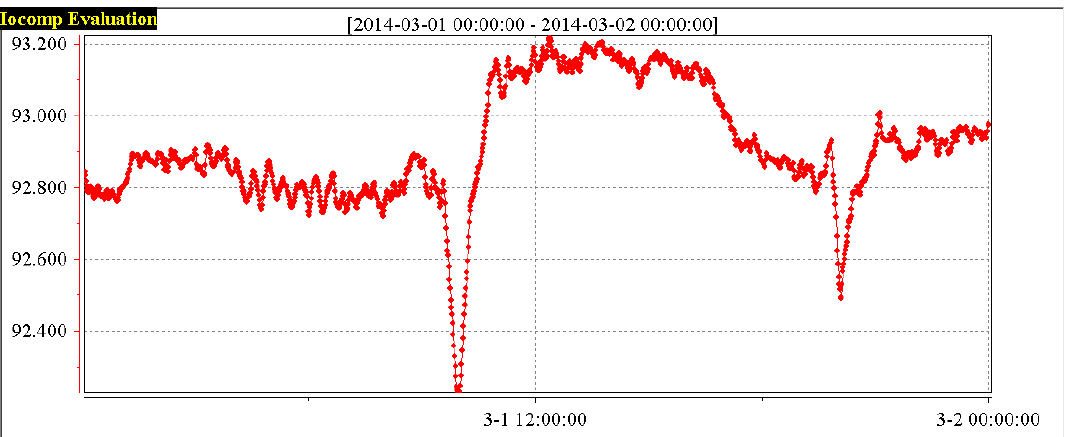
Figure 14. Five standardized variable